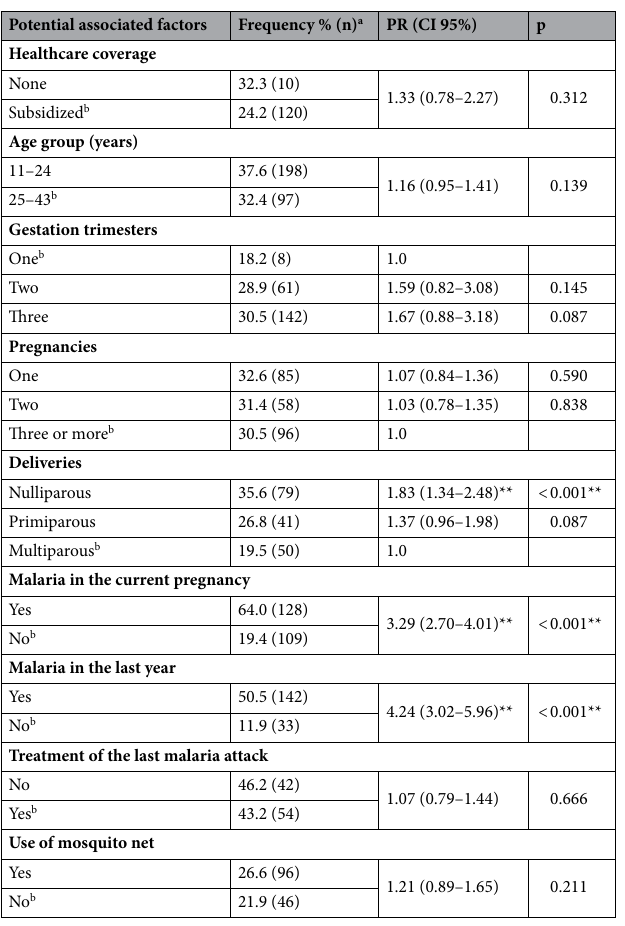
Table 2. Specific frequency of gestational malaria, prevalence ratio, and odds ratio, according to obstetric characteristics and malaria history. *p < 0.05. **p < 0.01. 95% CI 95% Confidence interval. a Proportion of positives in each subgroup, the total number of subjects in the subgroup indicated in each row is taken as the denominator b Reference group or denominator of the PR (Prevalence ratio).